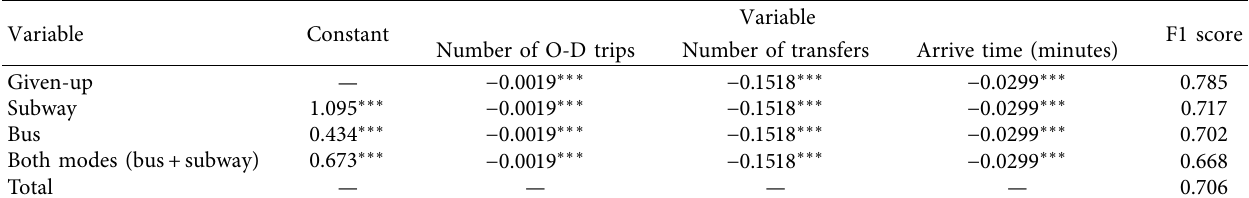
Table 4: Results of multinomial logit model.